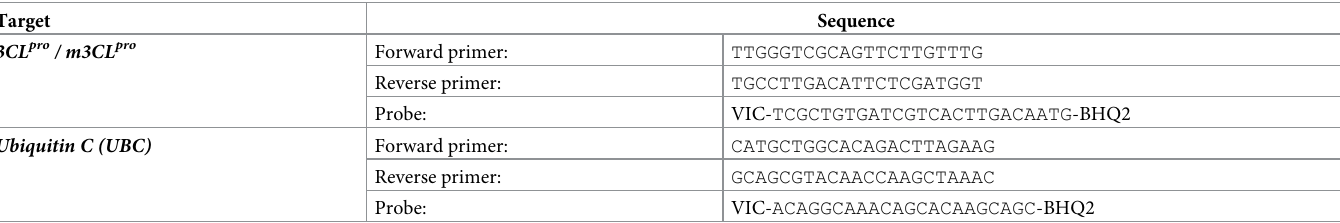
Table 1. Oligonucleotides used for quantitative real-time PCR.